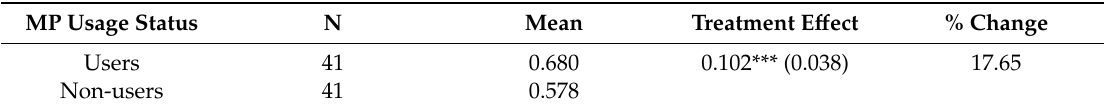
Table 4. Average treatment e ff ect of productive cost e ffi